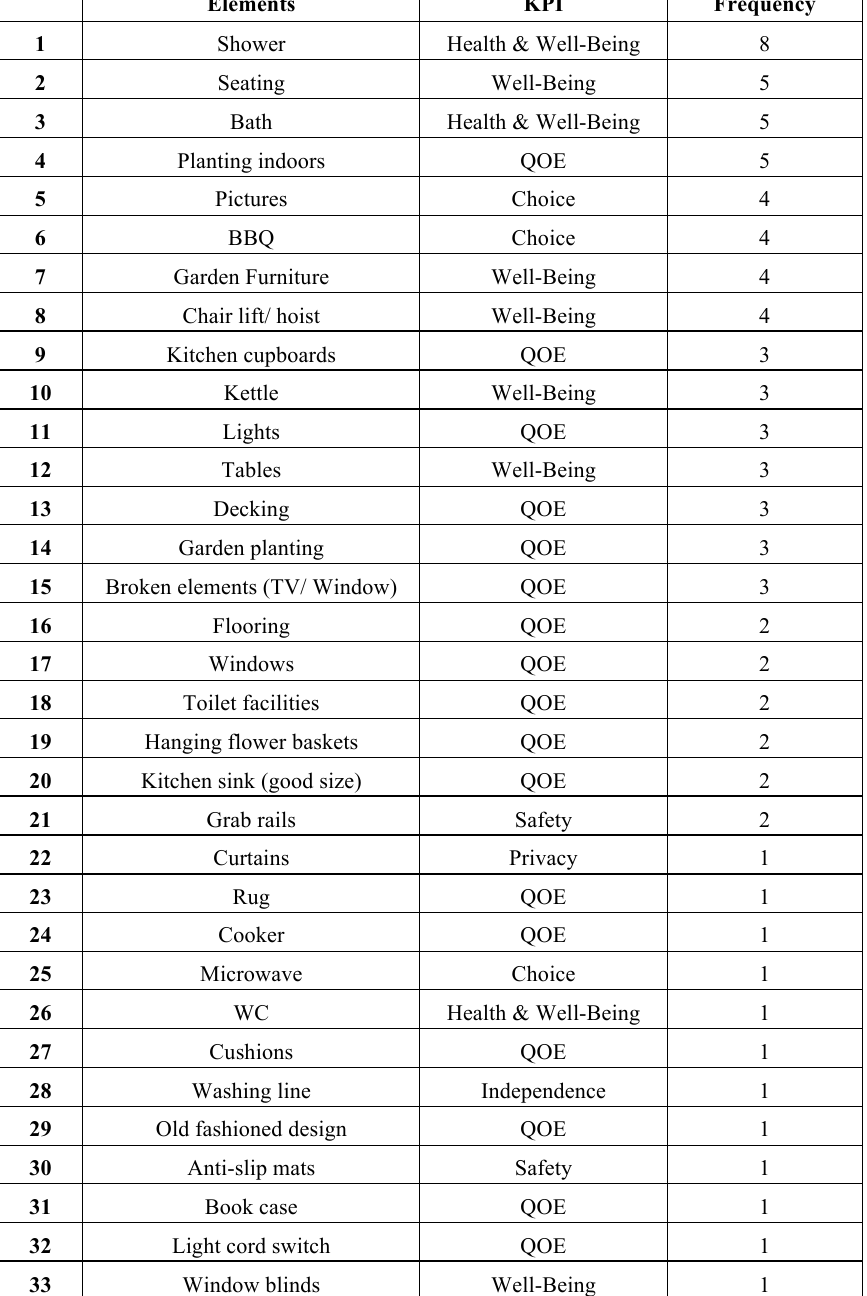
Table 5. Questionnaire responses related to elements ranked by frequency